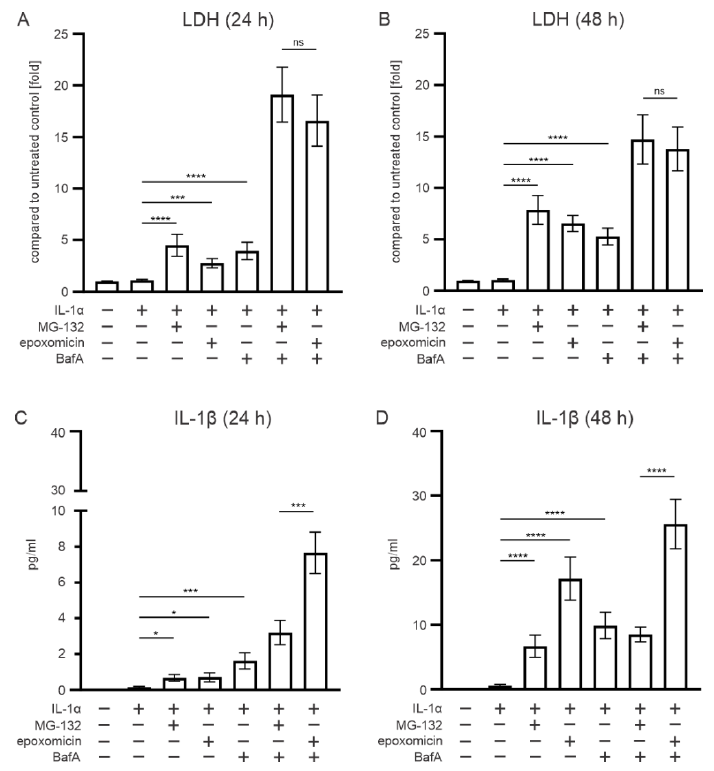
Figure 2. The effect of proteasome inhibitors epoxomicin or MG-132 with and without BafA on ( A , B ) cell viability and ( C , D ) IL-1 β production in ARPE-19 cells. Data of LDH and IL-1 β were combined from nine independent experiments, with four parallel samples in each group. The results are presented as mean ± SEM. * p ≤ 0.05, *** p ≤ 0.001, **** p ≤ 0.0001; ns, not significant.